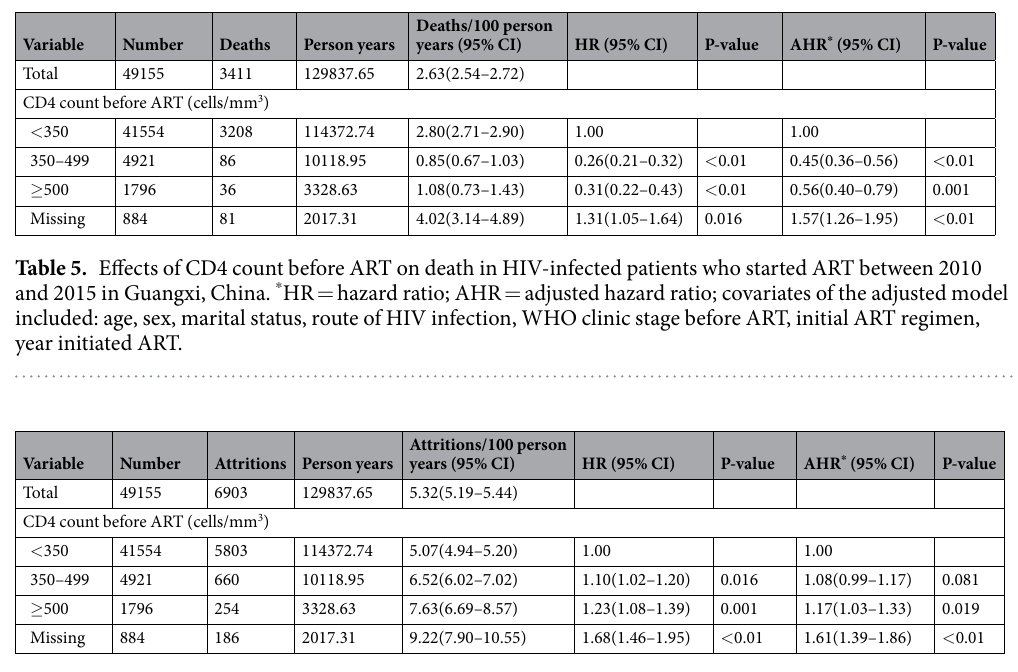
Table 6. Effects of CD4 count before ART on attrition in HIV-infected patients who started ART between 2010 and 2015 in Guangxi, China. * HR = hazard ratio; AHR = adjusted hazard ratio; covariates of the adjusted model included: age, sex, marital status, route of HIV infection, WHO clinic stage before ART, initial ART regimen, year initiated